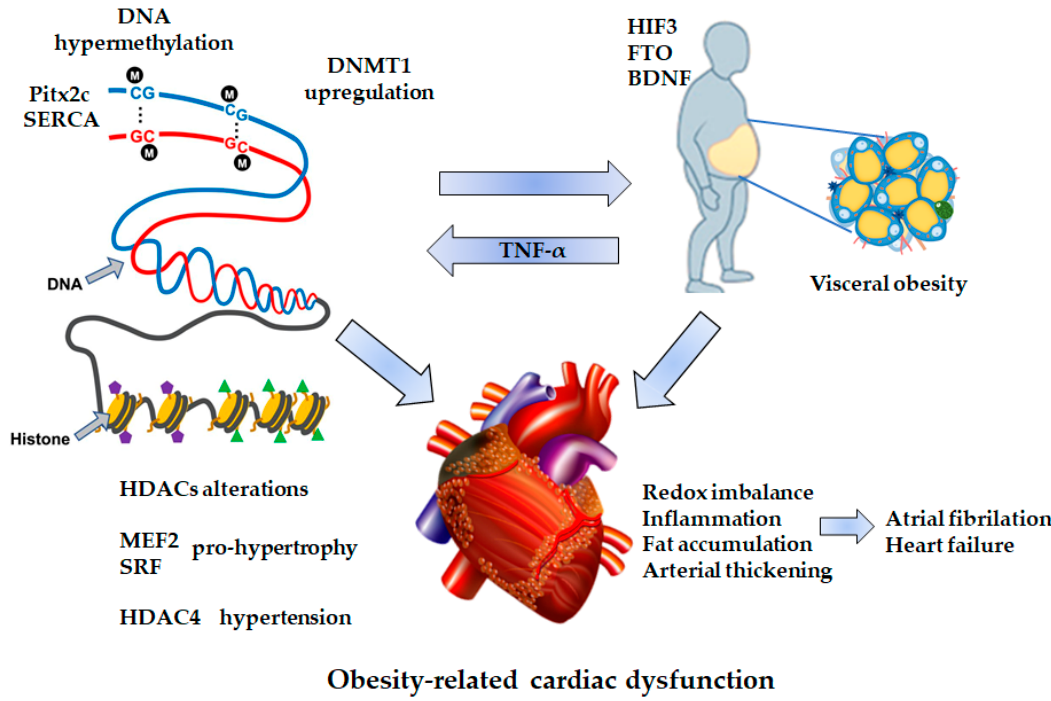
Figure 3. DNA and histone modifications in obesity-linked cardiac dysfunction. Visceral obesity causes systemic chronic inflammation and deregulation in hypoxia inducible factor 3 (HIF3), fat mass and obesity-associated protein (FTO), and brain derived neurotrophic factor (BDNF) gene methylation, as well as serum TNF- α increase. These events up-regulate DNMT1 and, in consequence, lead to DNA hypermethylation. Specifically, increased methylation in Pitx2c and sarco/endoplasmic reticulum Ca 2+ ATPase (SERCA) promoters provoke a decrease in expression, contributing to heart failure pathophysiology. HDAC4 is a master negative regulator of cardiac hypertrophy, where it is found oxidized, triggering de-repression of pro-hypertrophy genes like myocyte enhancement factor 2 (MEF2) and serum response factor (SRF). These molecular mechanisms lead to atrial fibrillation and heart failure. HDACs: histone deacetylases; HDAC4: histone deacetylase 4; DNMT1: DNA methyltransferase 1; Pitx2c: paired ‐ like homeodomain transcription factor 2, isoform c.